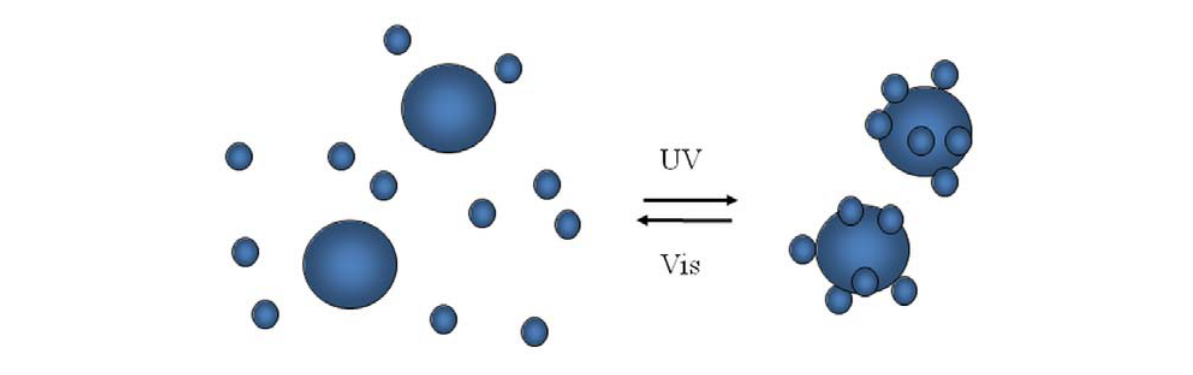
Figure 39. Photo-induced migration and assembly of small liposomes.